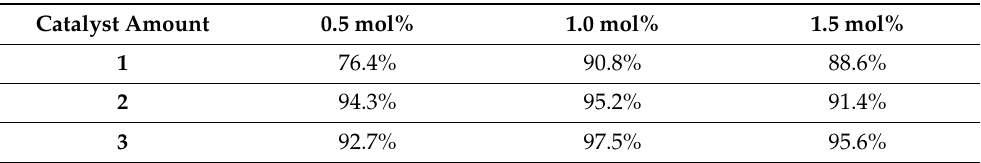
Table 4. Conversion (in %) of 4-NP with different catalyst amounts. Catalyst